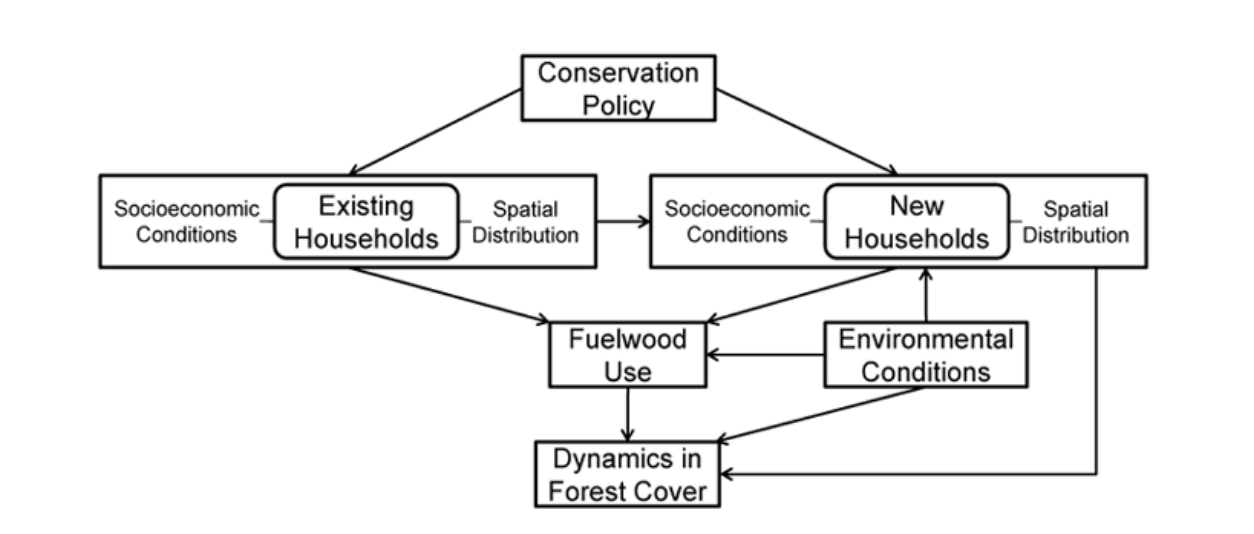
Fig. 2 . Conceptual framework of the